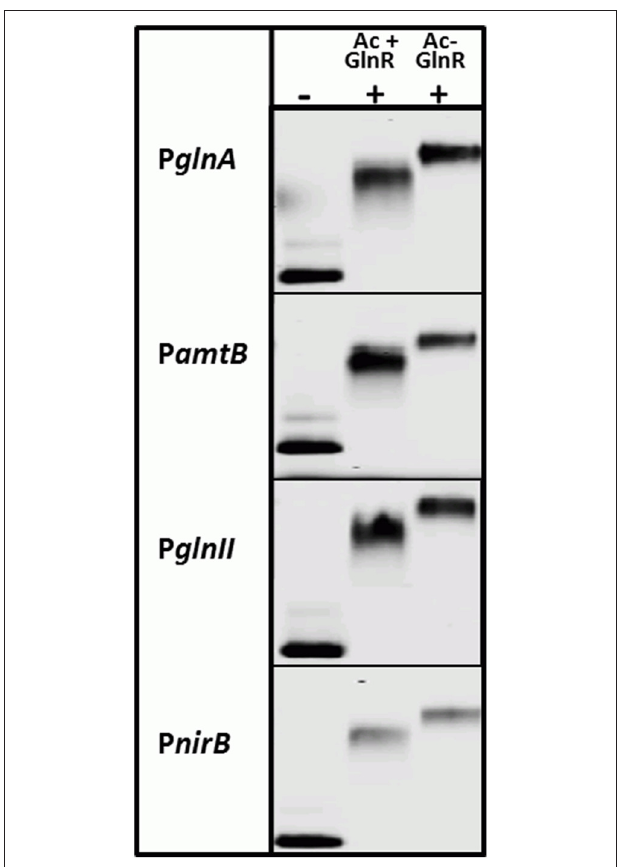
FIGURE 4 | EMSAs demonstrating different binding behavior of the acetylated Strep-GlnR and in vitro deacetylated Strep-GlnR. Lane ( − ), control, promoter regions of the known GlnR target genes (Cy5—labeled probe without Strep-GlnR protein). Lane ( + ), Cy5—labeled probe with 4 µ g of the acetylated Strep-GlnR (Ac + ) or deacetylated Strep-GlnR (Ac − ). The loss of the acetylation on Strep-GlnR was confirmed by Western blot analysis prior EMSAs. EMSAs were performed in the presence of the 300 × excess of the unlabeled, unspecific salmon sperm